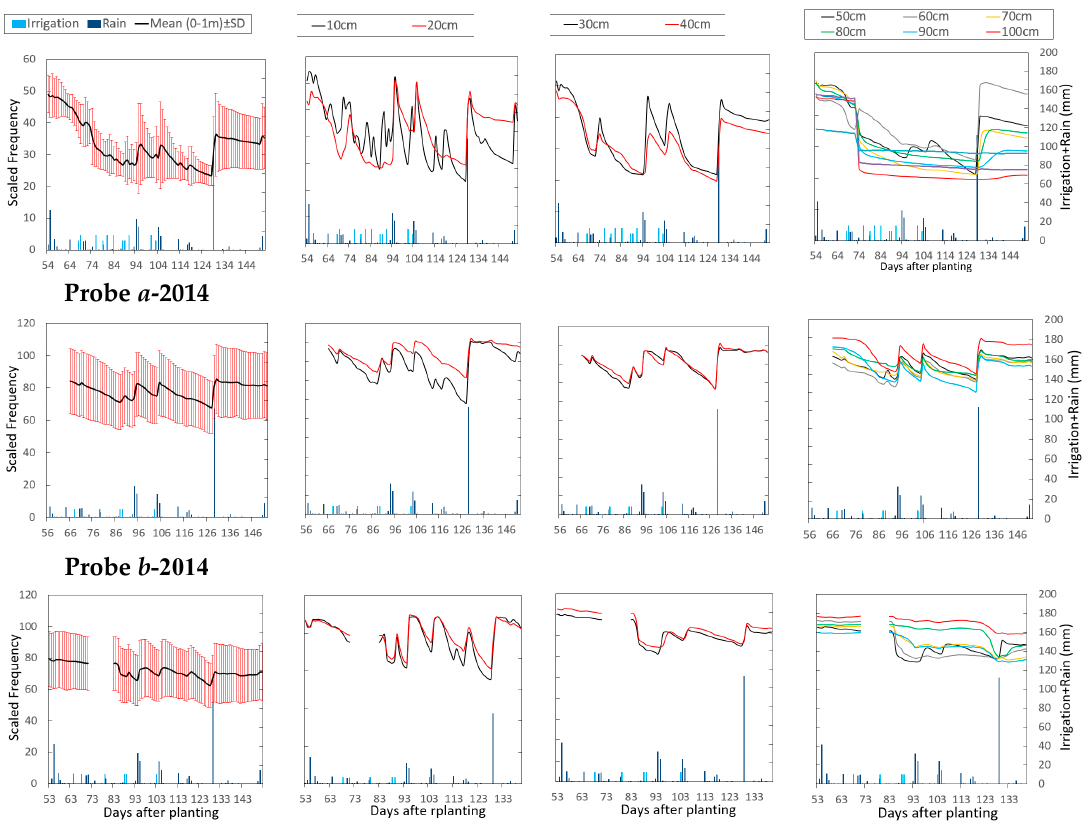
Figure 8. The change in soil moisture capacitance, measured as scale frequency (SF, Equation (4)), from 53 days after planting throughout the 2014 growing season in a 73-ha two-pivot supplemental irrigation field in west Tennessee. Light and dark blue bars show irrigation and rainfall, respectively. SF was measured using Agspy soil sensor probes at different locations and 10 depths from 0–1 m. In 2014, soil moisture probes a , b , and c were mainly located underneath the west pivot, representing the central area irrigated by both pivots, pie shape zone with lower irrigation, and farmer’s irrigation application, respectively.